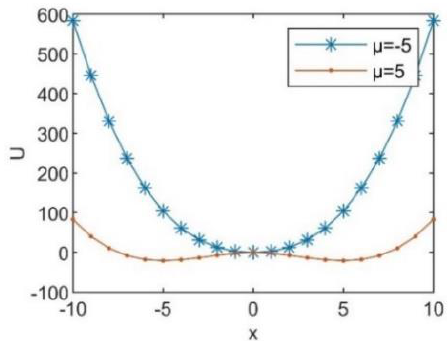
Figure 7. The bifurcating potential.